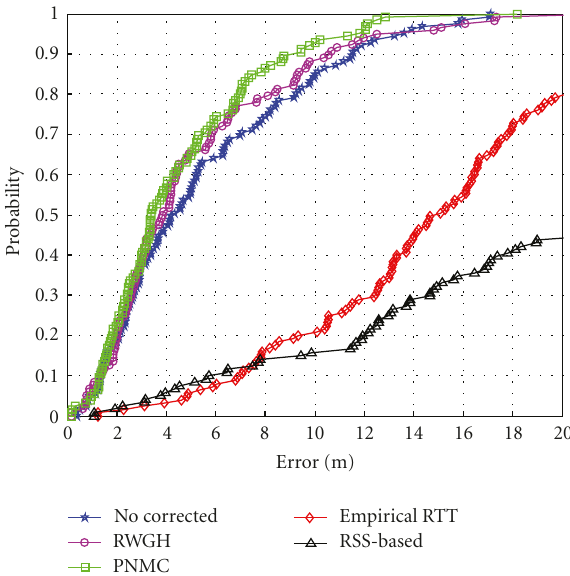
Figure 8: CDFs of errors performed with five di ff erent localization methods that have been tested in the second floor of the